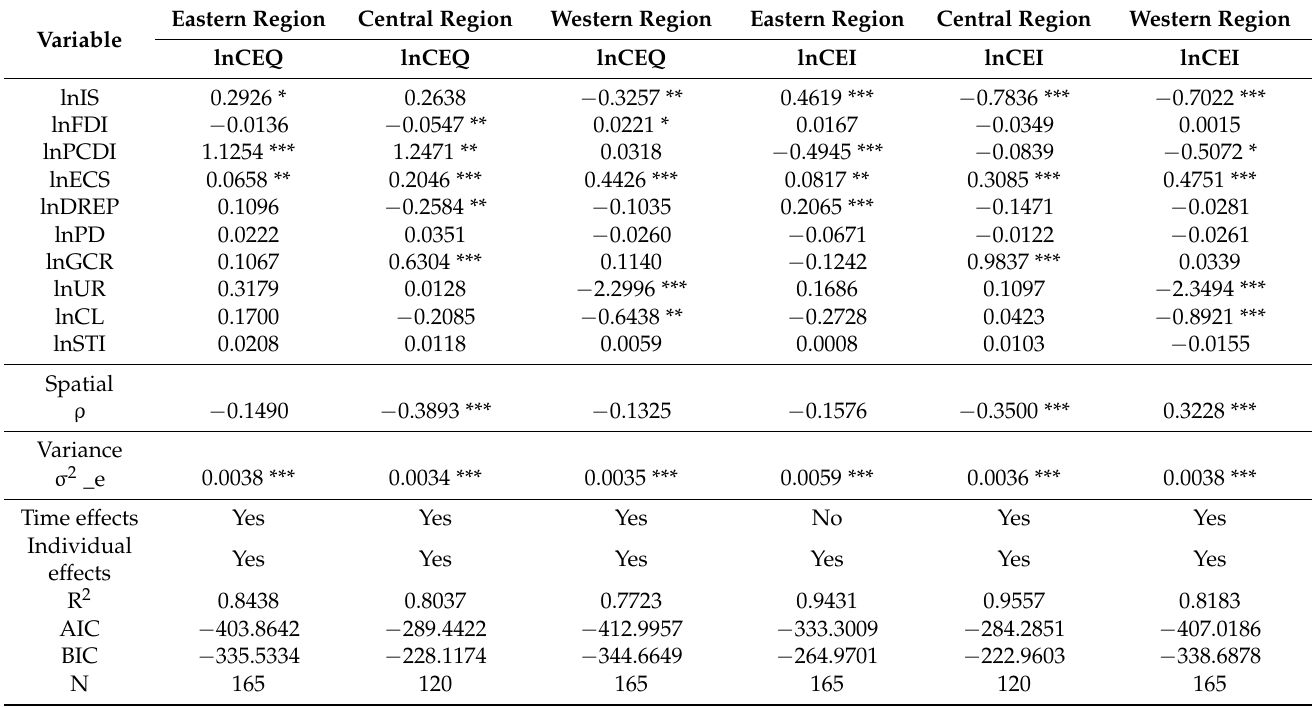
Table 11. Regression results of carbon emissions from urban production energy consumption by region